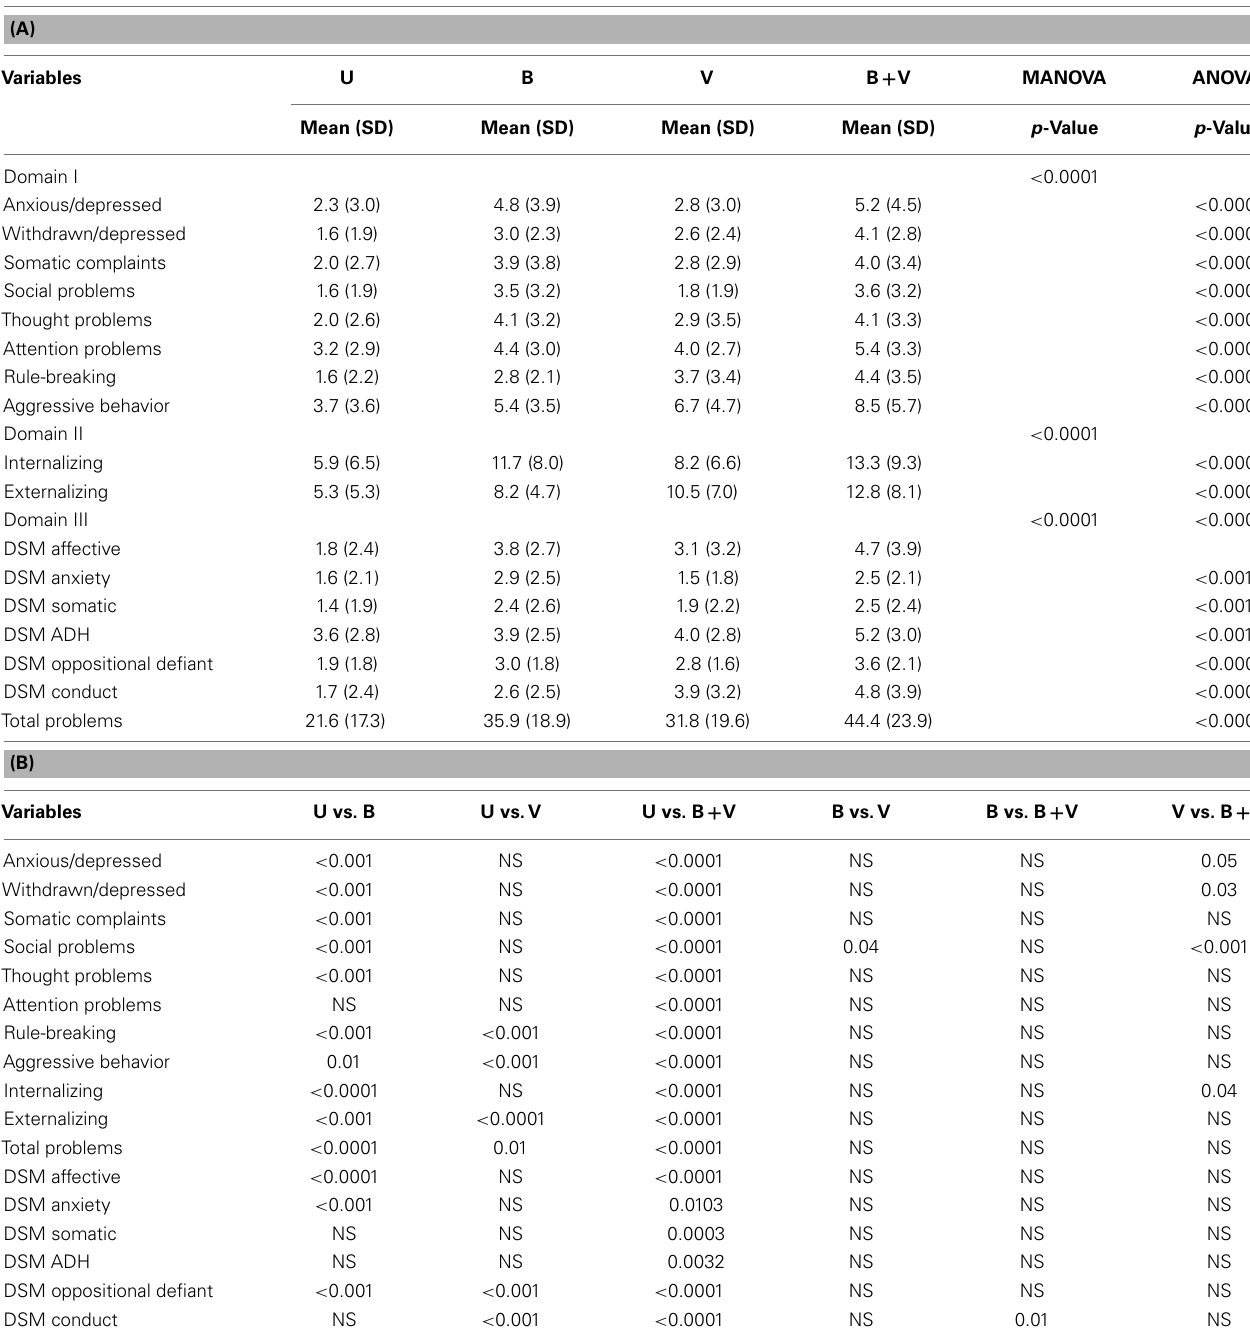
Table 5 | (A)Adjusted comparison of psychosocial and behavioral problems according toYSR raw scores. (B) Post hoc comparisons of raw scores obtained usingYSR